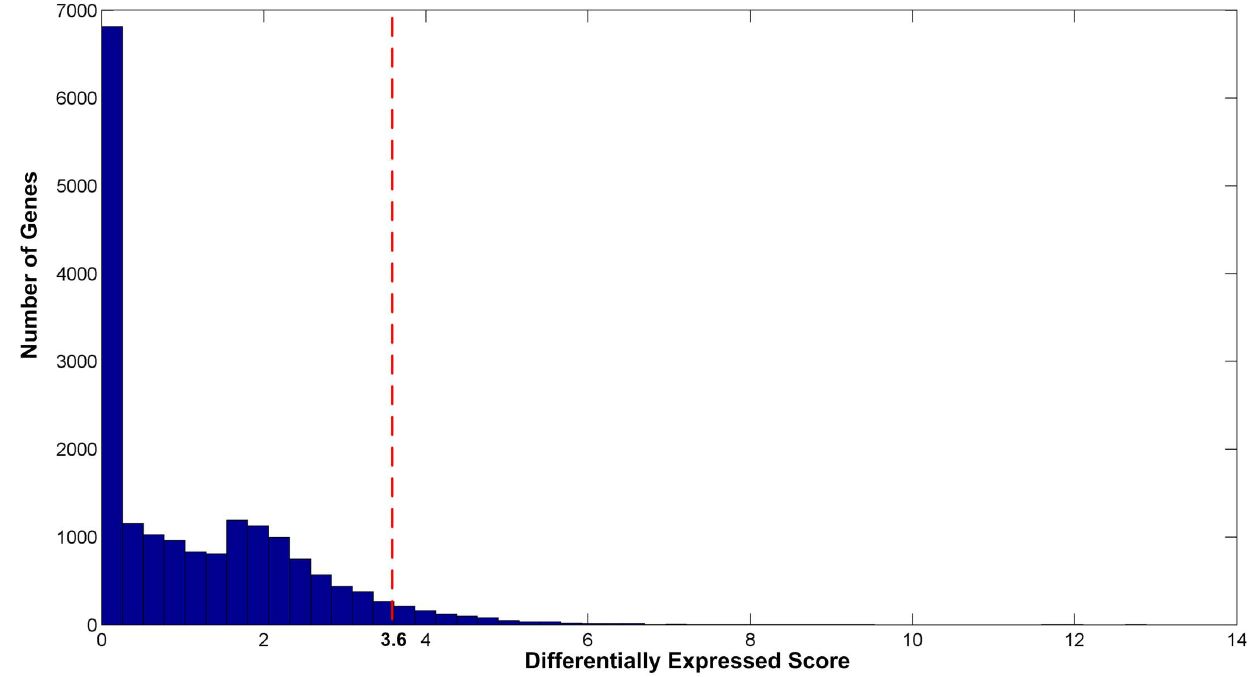
Figure 4. Statistical distribution of differentially expressed scores of all the genes in the microarray. SAM is used to compute the differentially expressed score of each gene. And the score of 3.6 ( P , 0.05) is considered as a cutoff to select deregulated genes.